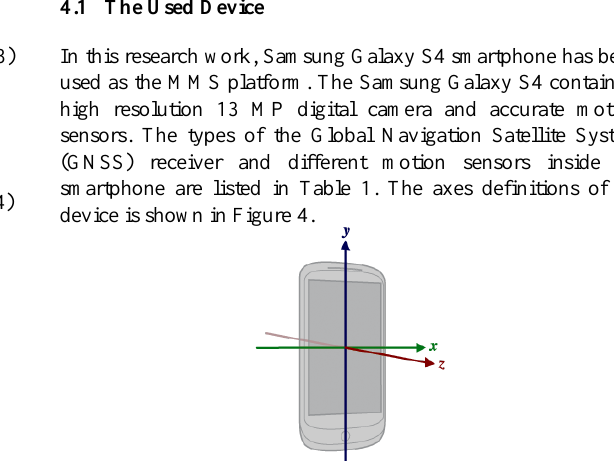
Figure 4. Samsung S4 axes